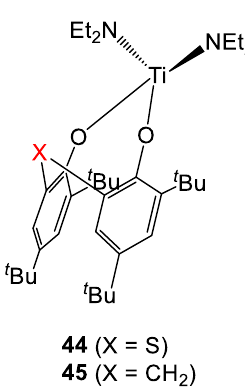
Table 14. ROP of cyclic esters catalyzed by Ti-diphenolate complexes 47 and 48 [26]. Entry Complex Monomer